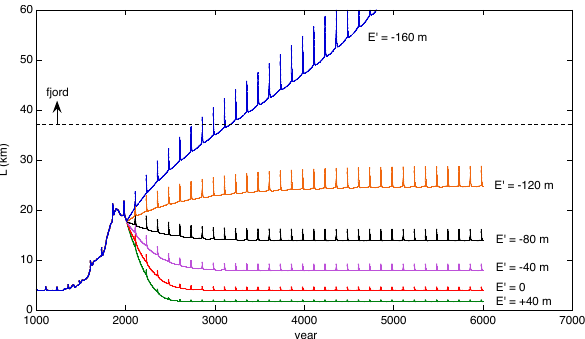
Fig. 12. Simulated evolution of Abrahamsenbreen for some selected values of the equilibium-2 Figure 12. Simulated evolution of Abrahamsenbreen for some se- line altitude (relative to the mean value for the period 1989-2010). 3 lected values of the equilibrium-line altitude (relative to the mean value for the period 1989–2010).